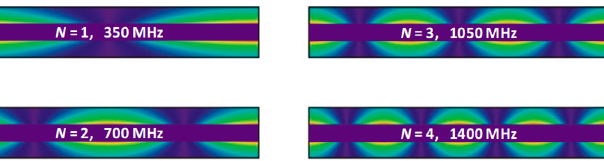
Figure 2. Calculated E-field distribution of the first four modes within an open-ended coaxial resonator (Scale: red is high, purple is low).